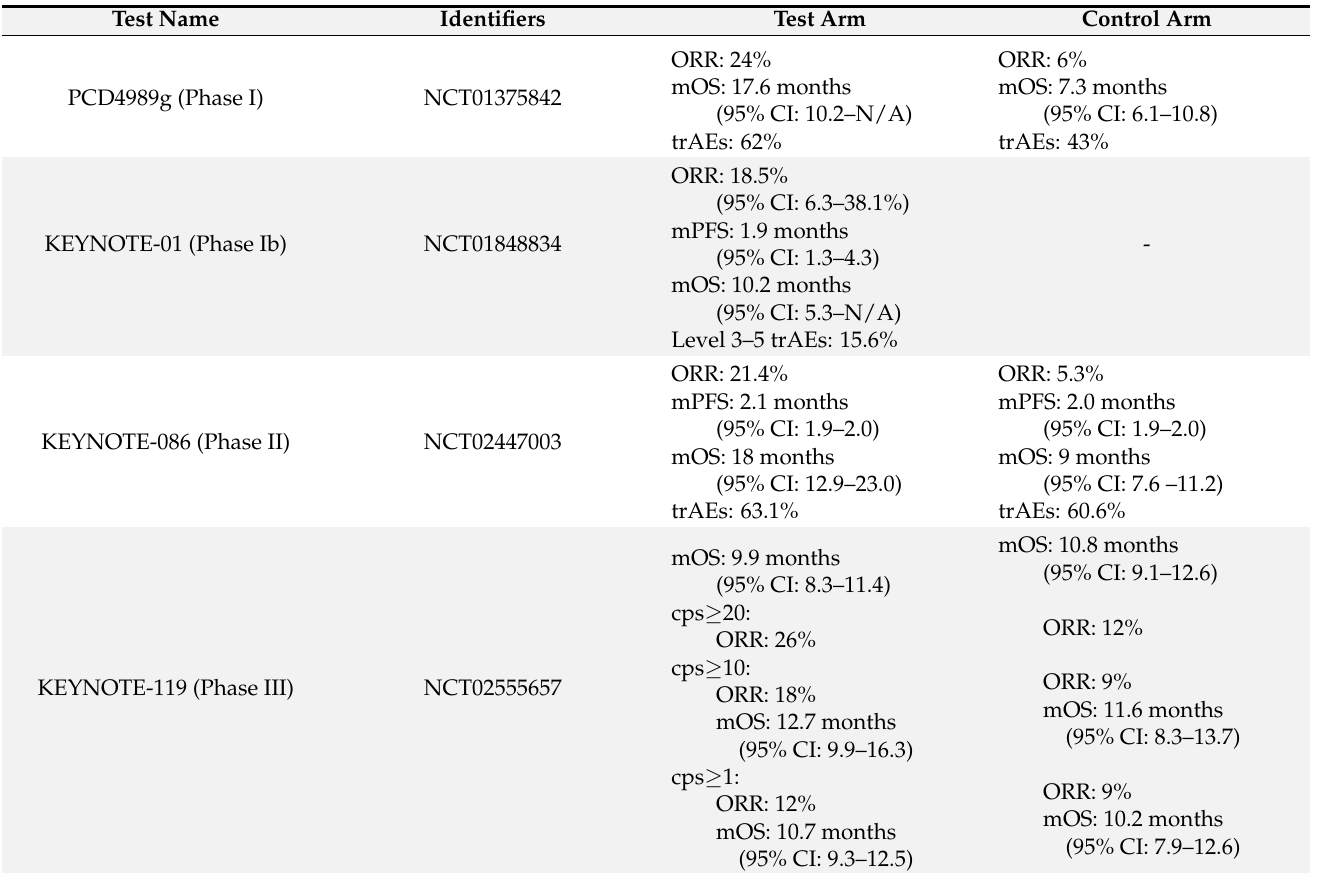
Table 4. Clinical trial results for PD- 1/PD-L1 inhibitor